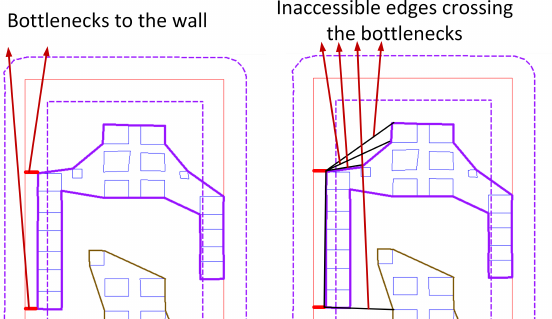
Figure 11. Detecting bottlenecks between a wall and the boundary of an obstacle group and identifying inaccessible edges crossing the